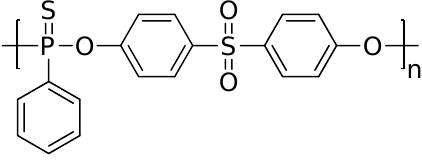
) curves of neat PC and flame retardant PCs calculated α